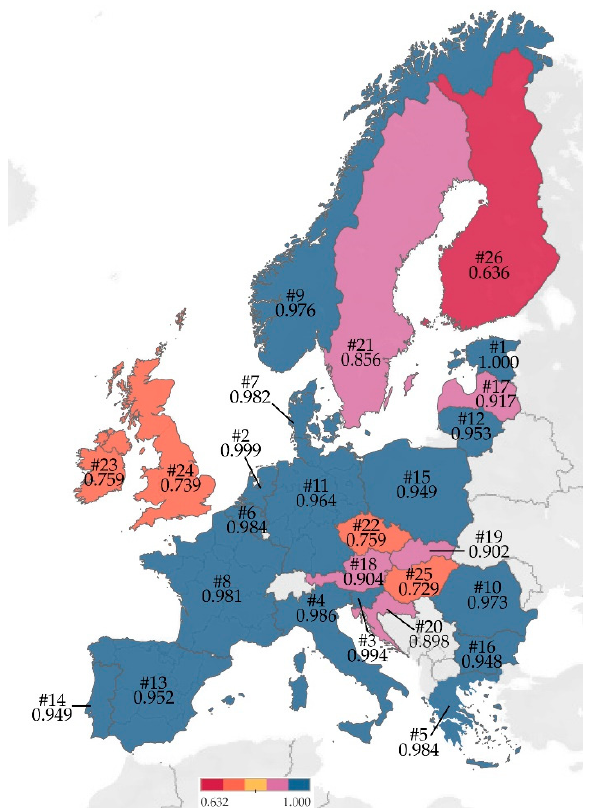
Figure 8. Efficiency scores map, Window Width (7) (2005–2019).